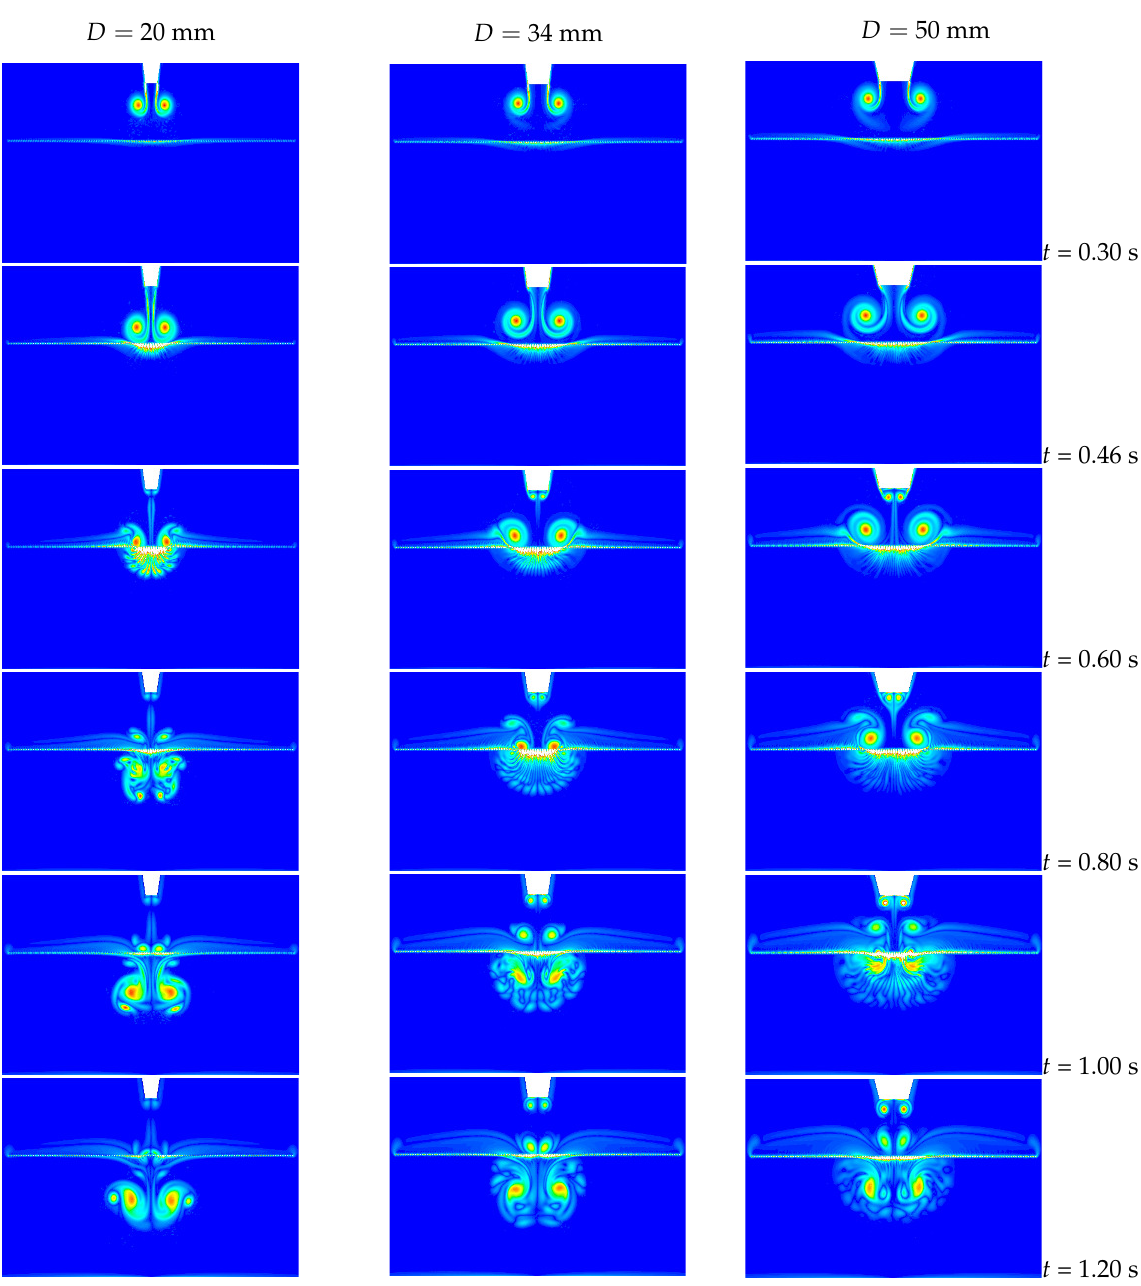
Figure 14. Vortex ring formation and interaction vs. piston diameter ( φ =